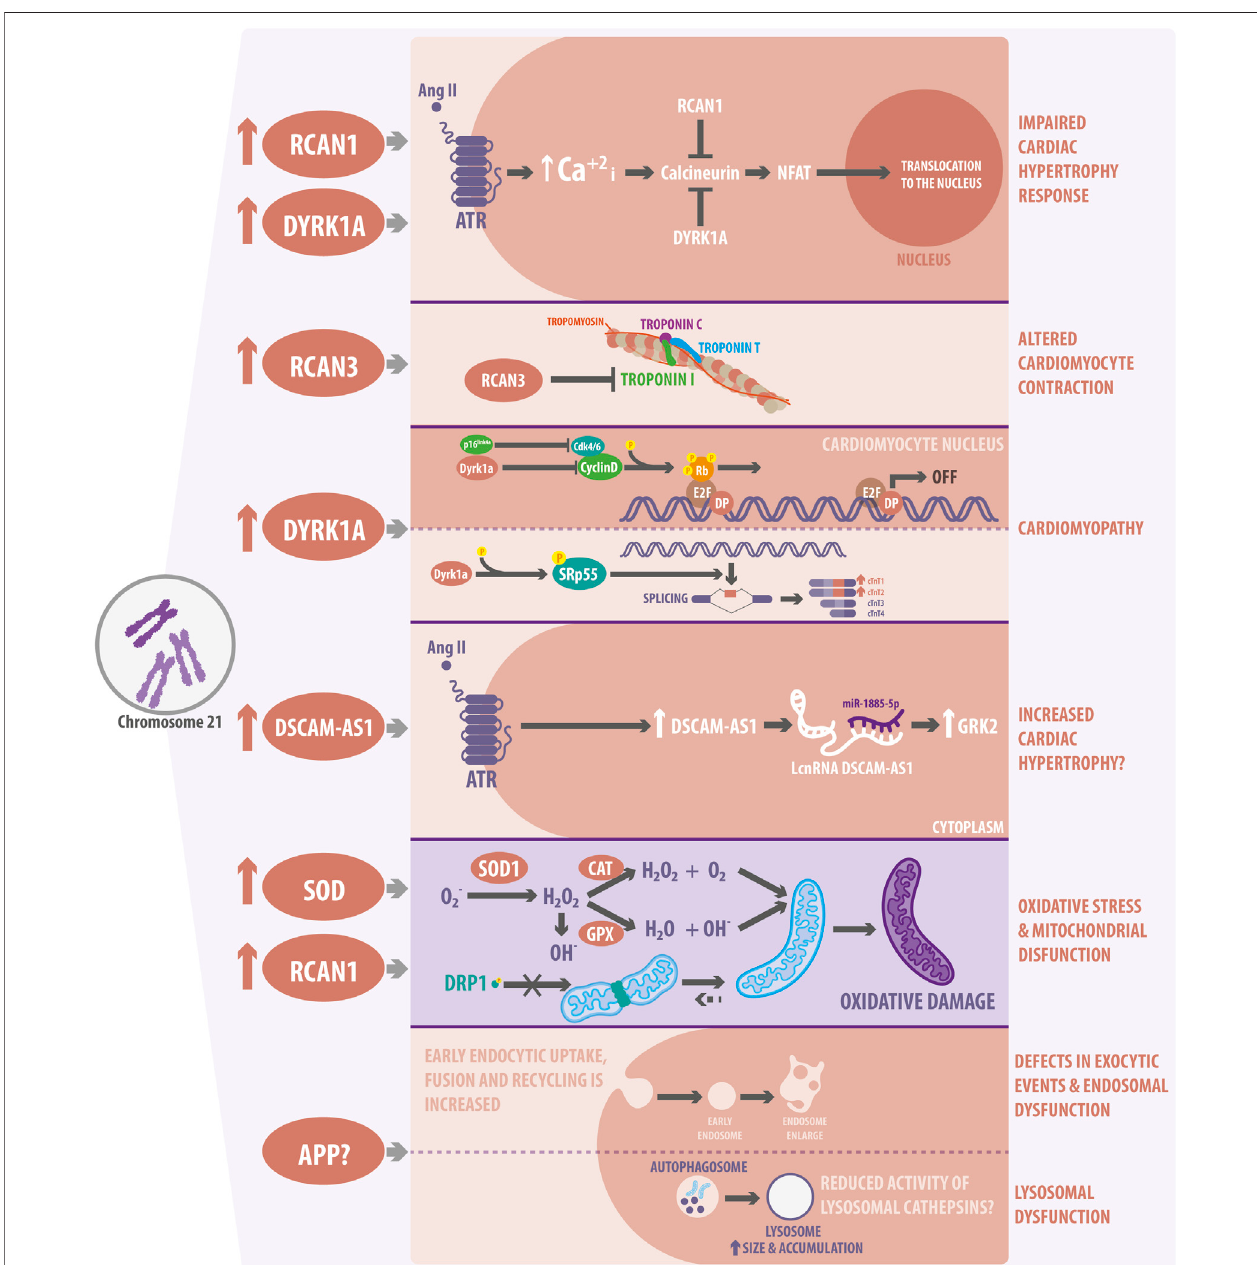
FIGURE 2 | Cardiovascular molecular pathways and organelle alterations in Down Syndrome (DS). The overexpression of a few Hsa21 genes has been linked to alterations in cardiac function and development. RCAN1 and DYRK1A overexpression might impair cardiac hypertrophy response in DS by inhibiting CN activity and decreasingNFATnucleartraslocation.RCAN3canaltercardiomyocytecontractionbyinteractingwithTroponinI.DYRK1Acanalsobeinvolvedincardiomyopathiesdue to the altered regulation of cardiomyocyte proliferation and development. In this regard, DYRK1A interacts with D-cyclin family proteins and suppress Rb/E2F signaling. DYRK1A also modulates the splicing of cardiac troponin variants, promoting the inclusion of exon fi ve into TNNT2 through SRSF6 phosphorylation. DSCAM- AS1, which is overexpressed in DS, increases after Angiotensin II stimulation and interacts with miR-188-5p to stimulate GRK2, promoting an hypertrophic response. Moreover,overexpressionoftheDSCAM-AS1lncRNAhasbeenalsorelatedtocardiomyopathy.Intermsoforganelles,SOD1overexpressionincreasesROSlevelsand oxidative stress, producing H 2 O 2 accumulation, which fi nally leads to mitochondrial dysfunction. Additionally, RCAN1 regulates the connectivity of the mitochondrial networkanditsfunction,byregulatingthephosphorylationofthemitochondrial fi ssionprotein,DRP1.Finally,trisomiccellsshowdefectsintheendocyticandendosomal pathways.TheyshowdecreasedlysosomalactivityandautophagydysfunctionrelatedtoAPPoverexpression.However,ifAPPisresponsibleforthelysosomesdefects observed and described in cardiac DS cells is still not known.